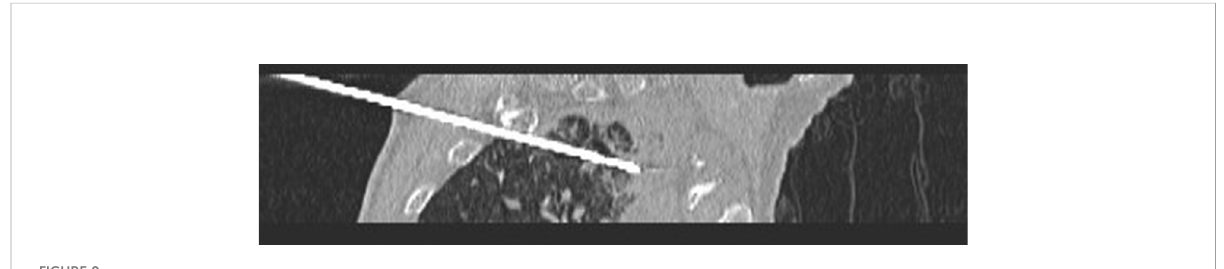
FIGURE 9 Intraoperative scan: the Reconstructed CT